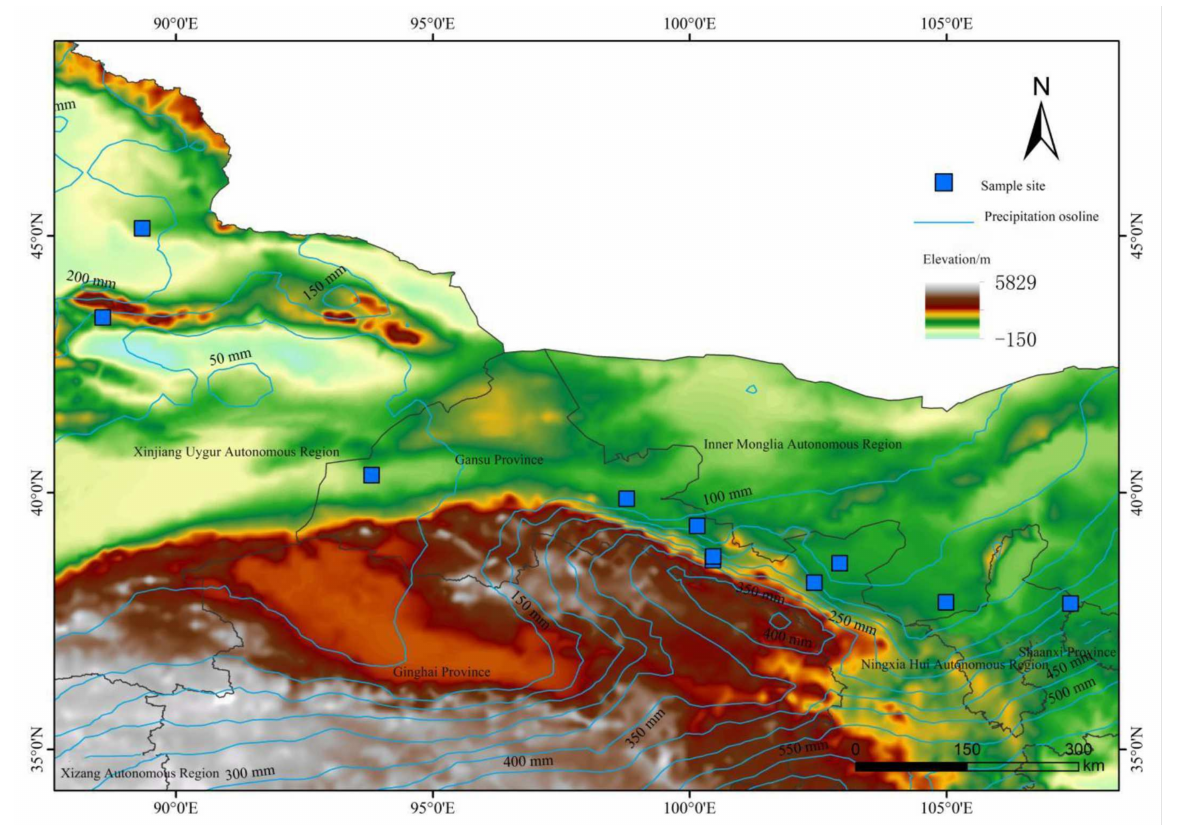
Figure 1. Spatial distribution of sampling points for Zygophyllaceae plants in arid and semi-arid areas of